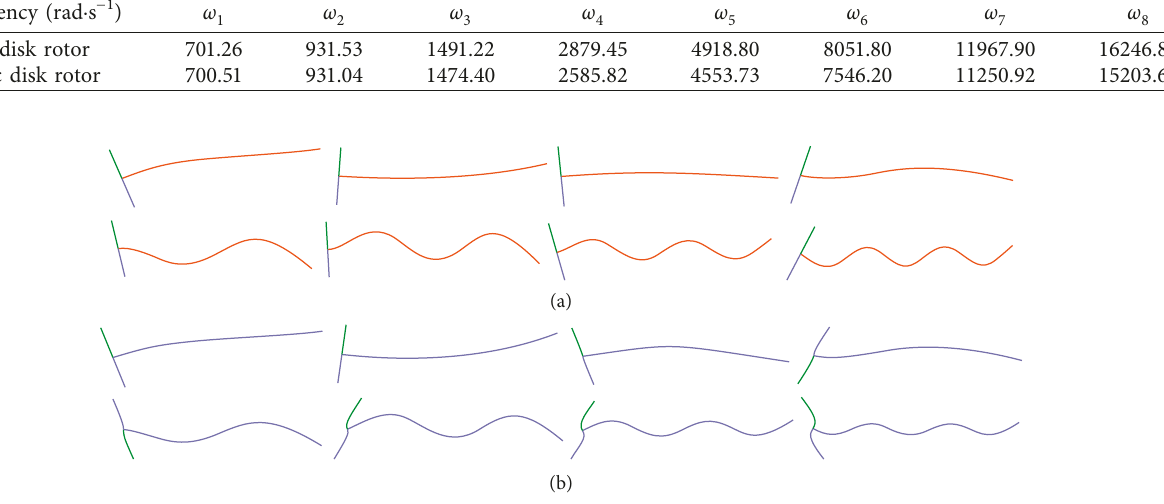
Figure 4: Mode shape comparison of the different rotor models: first eight mode shapes of (a) flexible shaft and rigid disk rotor system and (b) flexible shaft and elastic disk rotor system.